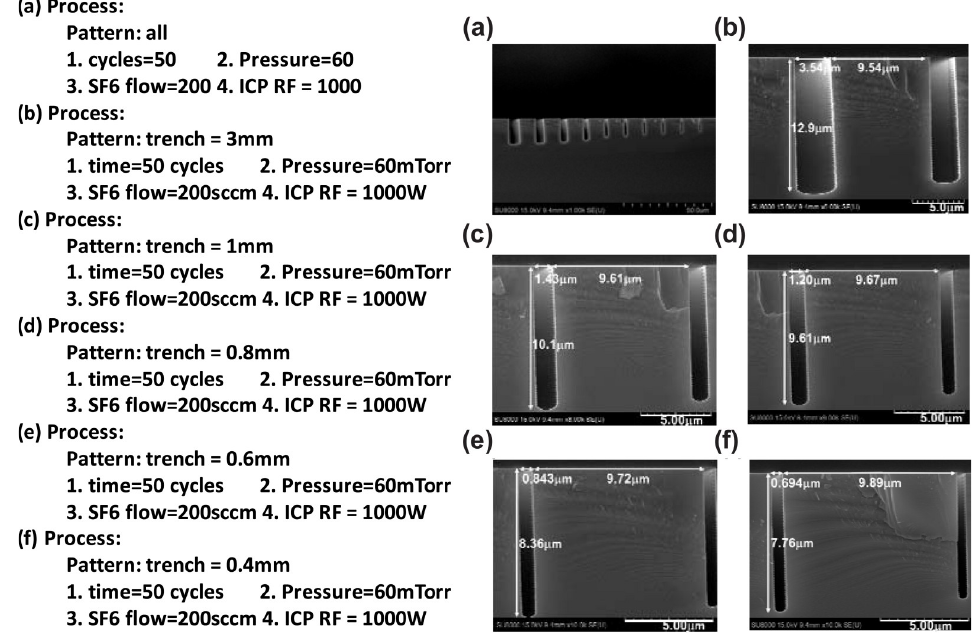
Fig 8. Scanning electron microscope images for different process conditions.